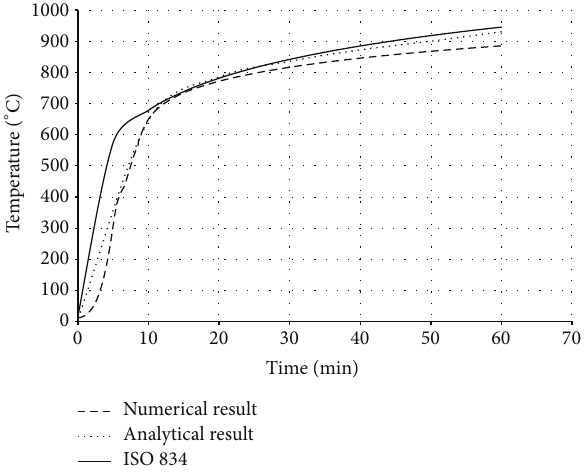
Figure 8: Comparison of 𝑇 - 𝑡 Curves at point 1.